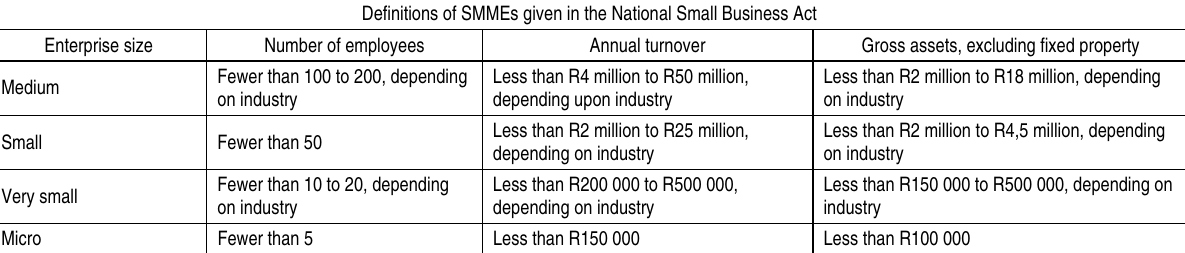
Table 1. Broad definitions of SMMEs in the National Small Business Act Definitions of SMMEs given in the National Small Business